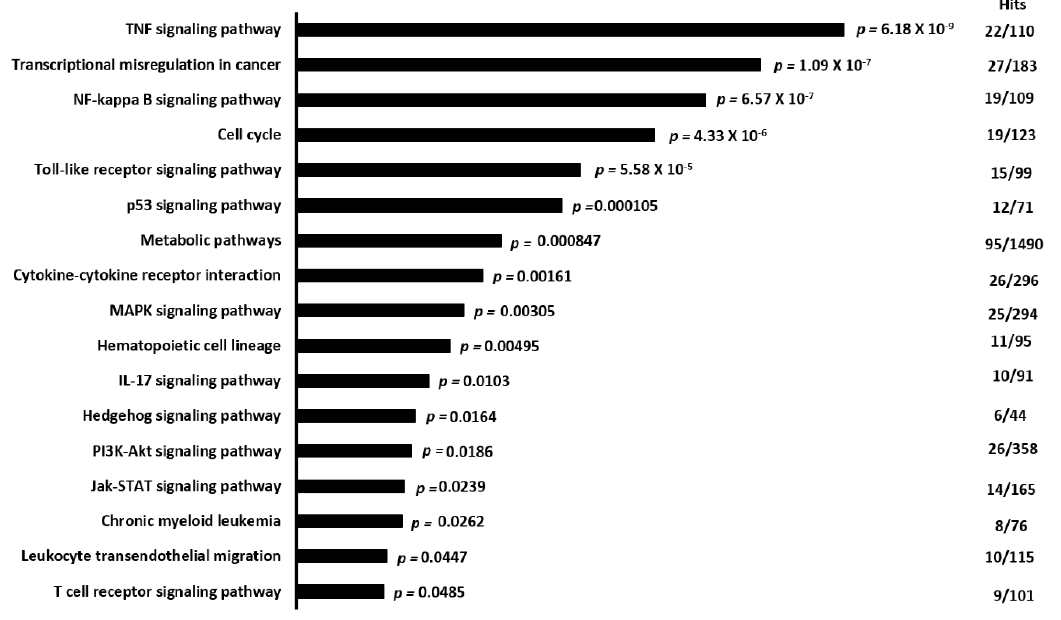
Figure 3. Pathway analysis of modulated genes between WT and KO HSPCs after FLT3L treatment. Bars represent the significance of hits. On the right, the number of differentially expressed genes (hits) as well as total number of genes per pathway are given.